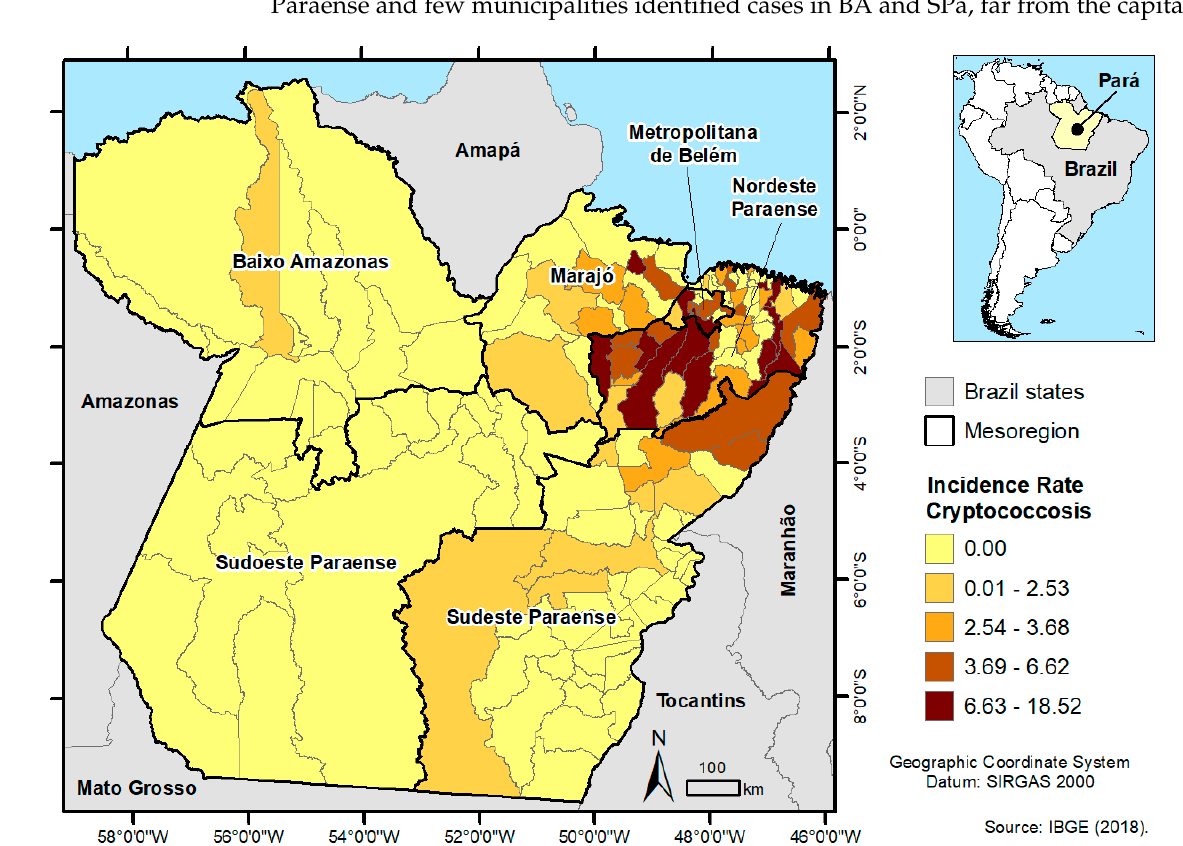
Figure 2. Spatial distribution of the incidence rate of cryptococcosis according to the population of the mesoregions of the Pará per 100,000/inhabitants. (IBGE). 2008–2018, JBBUH, Pará, Brazil. the mesoregions of the Par á per 100,000/inhabitants. (IBGE). 2008–2018, JBBUH, Par á ,